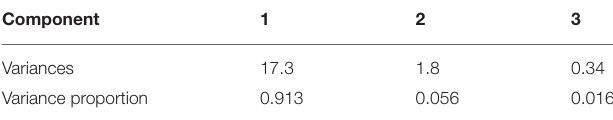
TABLE 1 | Variances and variance proportion of the first three components in the comparison between environmental, health and agricultural production data. Component 1 2 3 Variances 17.3 1.8 0.34 Variance proportion